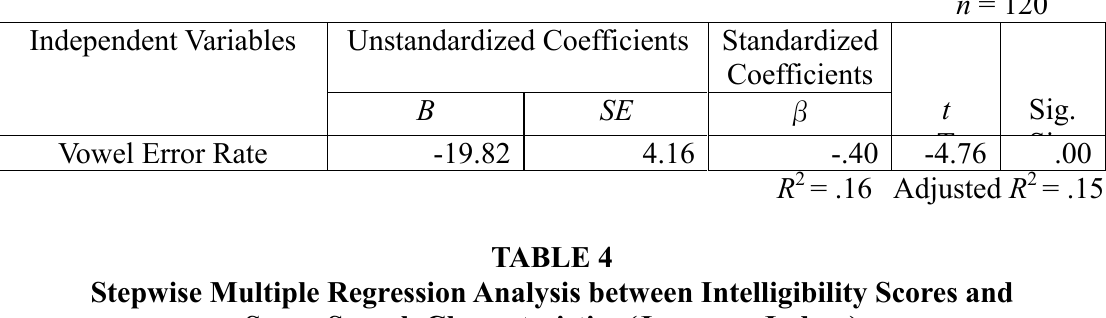
Stepwise Multiple Regression Analysis between Intelligibility Scores and Seven Speech Characteristics (American Judges)